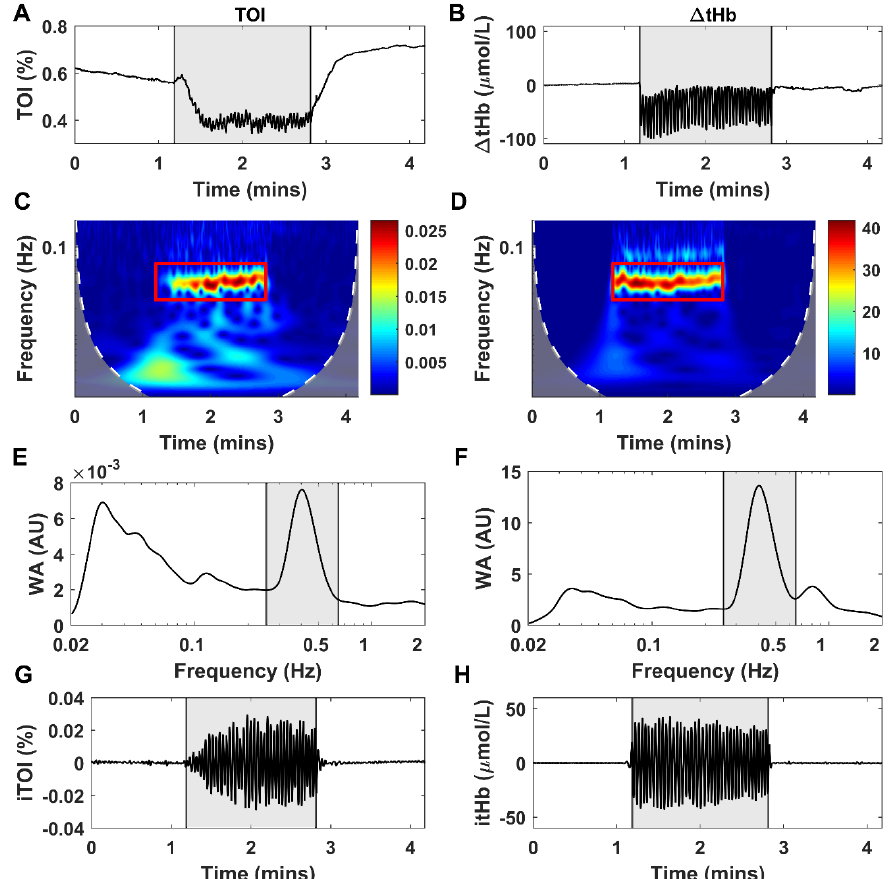
Figure 1. Hemodynamic oscillations induced by muscle contraction in tissue oxygenation index (TOI) ( A ) and total hemoglobin signal ( ∆ tHb) ( B ) signal with the gray box showing the exercise phase. Scalograms of TOI ( C ) and ∆ tHb ( D ) signal after wavelet transform, with the red box showing the contraction-induced component in the corresponding signal. Time-averaged wavelet amplitudes of TOI ( E ) and ∆ tHb ( F ) signal, with the gray box showing the frequency component related to contraction. Inverse wavelet transform of contraction-related frequency component in TOI ( G ) and ∆ tHb ( H ) signal, with the gray box showing the exercise